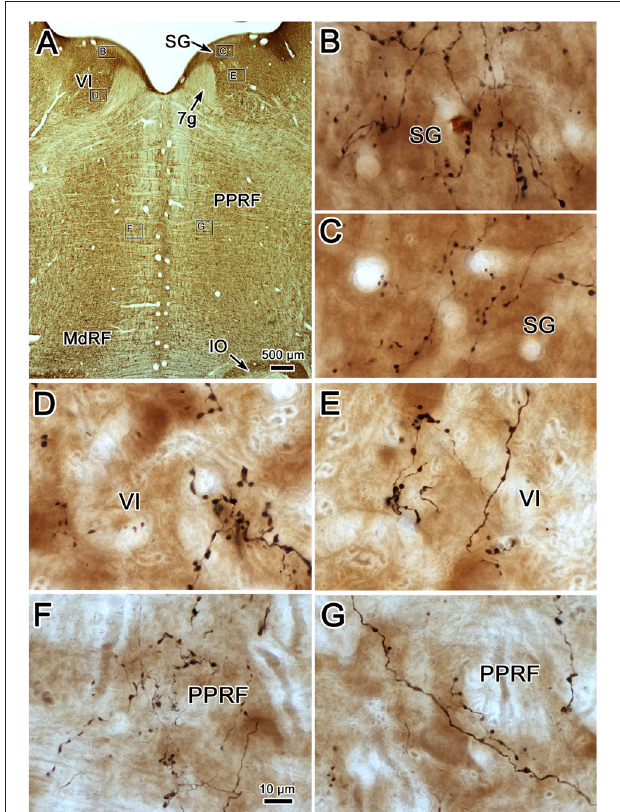
(A) Low magnification photomicrograph of a section through the abducens nucleus showing the location of the higher magnification plates (labeled boxes) in this uncounterstained section. The images were taken from the ipsilateral and contralateral supragenual region (SG; B,C , respectively), ipsilateral and contralateral abducens nucleus (VI) ( D,E , respectively), and ipsilateral and contralateral PRF ( F,G , respectively). Note the larger number of boutons ipsilaterally in the PRF. The case shown is the same as illustrated in Figures 4 , 5 . (Number of 1.0 µ m Z axis planes merged: B,E,G = 10, C,F = 13, D =